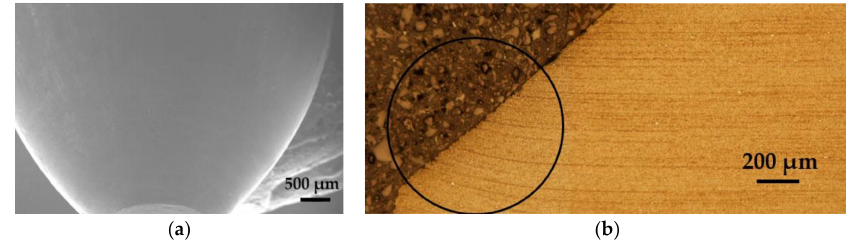
Figure 3. The active punch surface after 1500 strokes: ( a ) SEM (scanning electron microscopy) analyse; ( b ) profile.